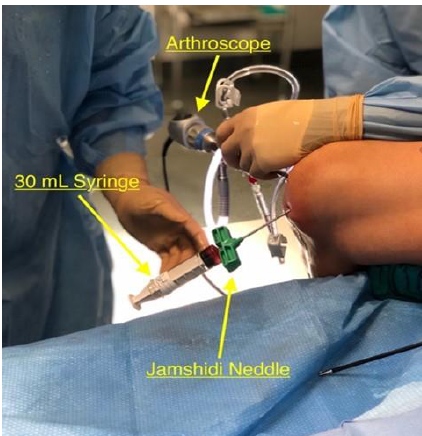
Figure 3. Harvest setup. The knee is flexed over the side of the table and the Jamshidi needle is impacted into the intercondylar notch of the femur with a pretreated 30 mL syringe. The arthroscope is in the anterior-lateral portal for visualization.